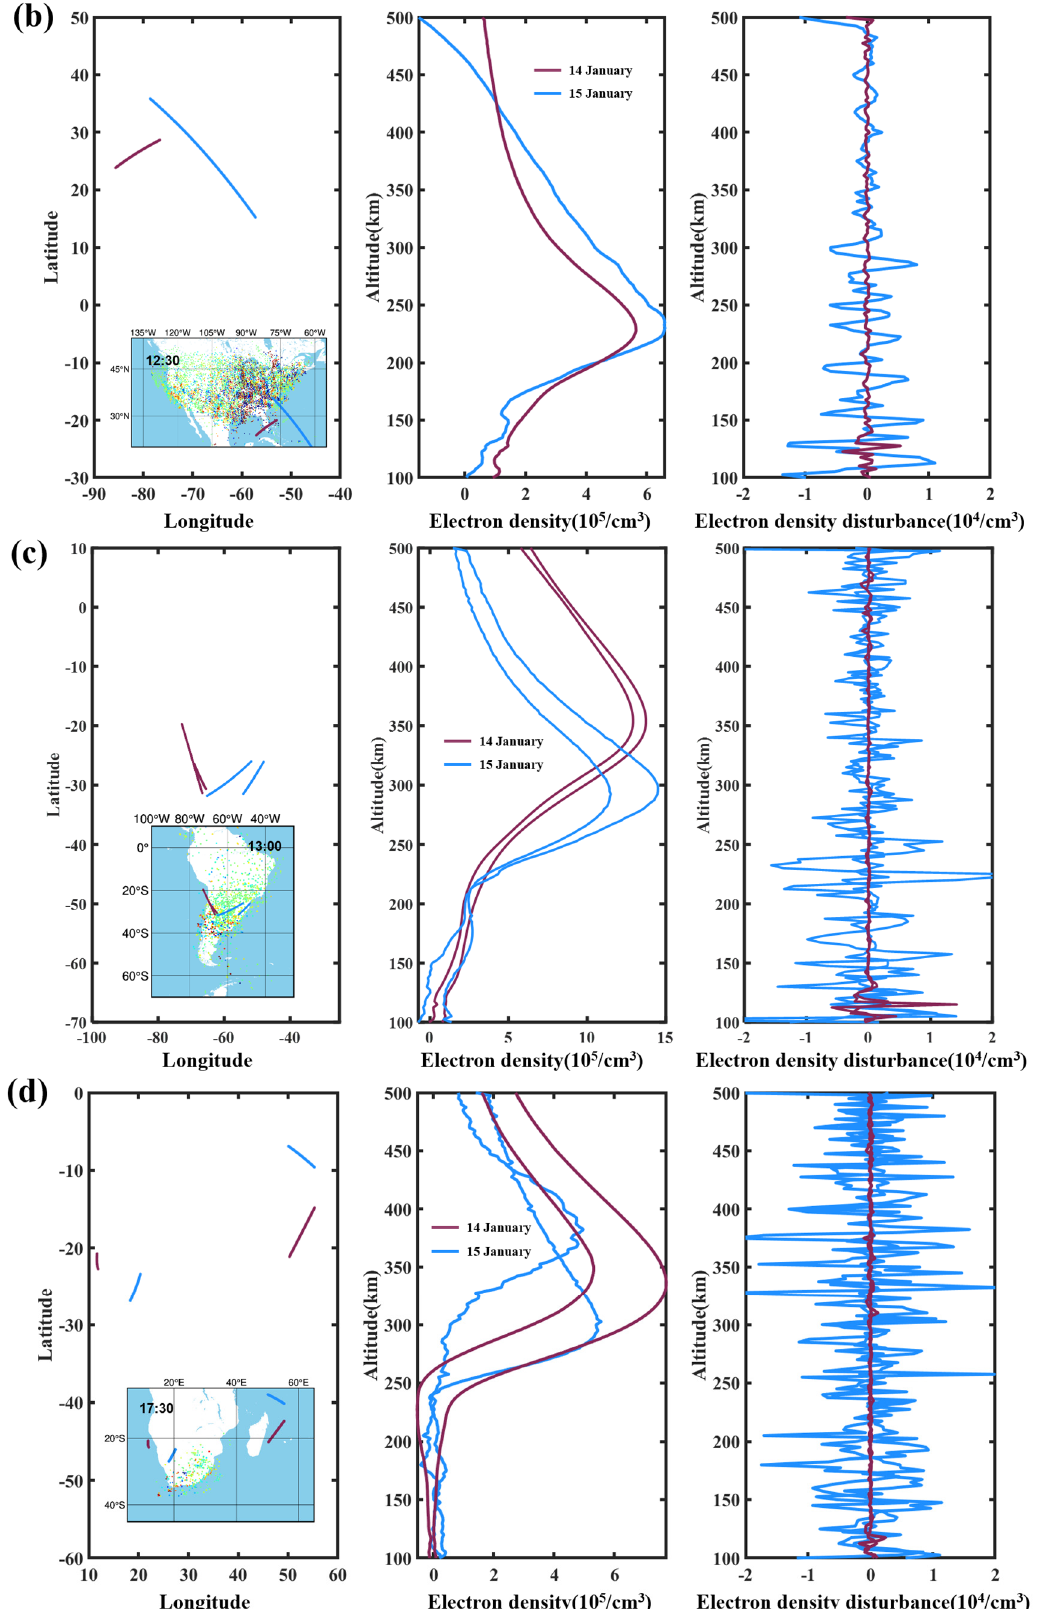
Figure 9. Distribution of profiles and their disturbances in each area, blue indicates the profile on the day of the eruption, and purple indicates the profile on the day before the eruption. ( a ) In China ( b ) In the United States ( c ) In South America ( d ) In South Africa.